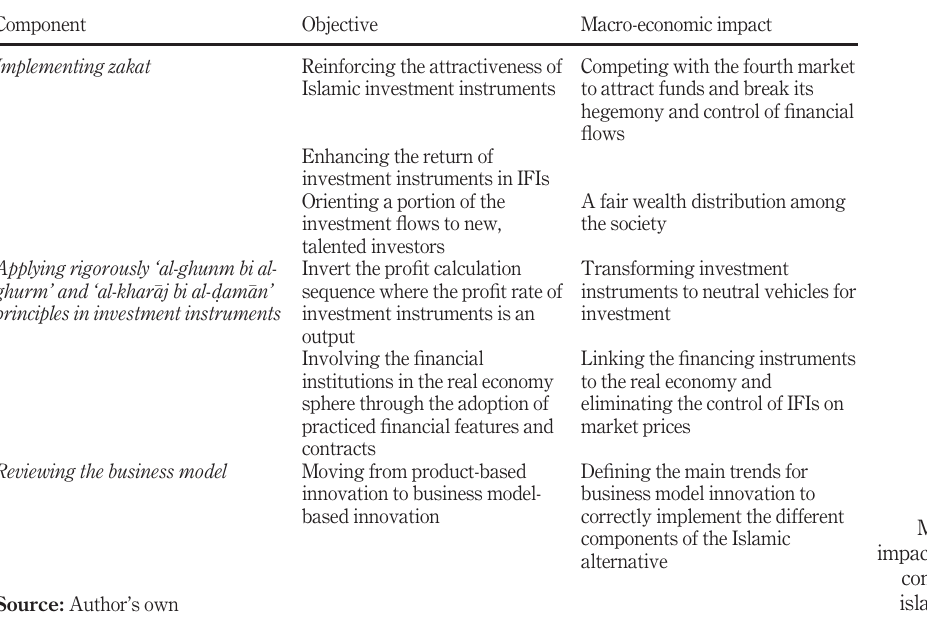
impact of the various components of